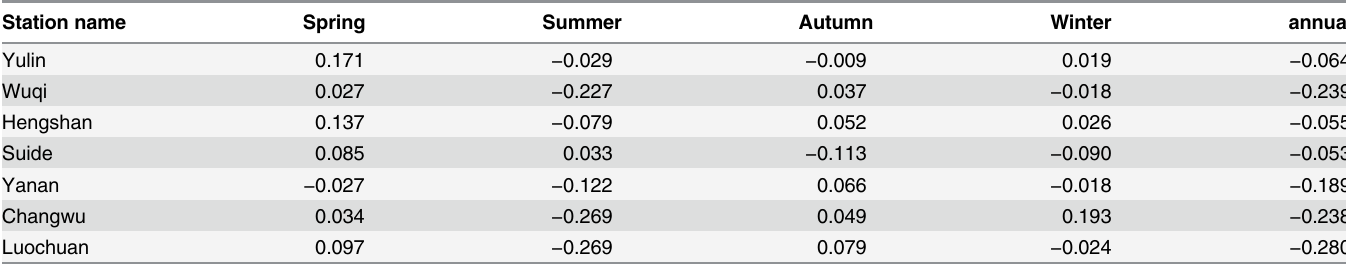
Table 5. Lag – 1 serial correlation coefficients for precipitation